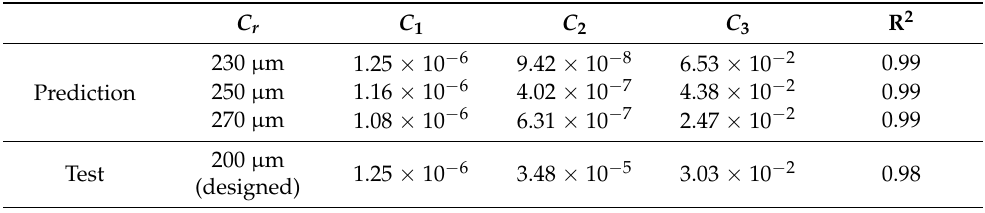
Table 2. Curve fitting functions of the static load versus the displacement from the prediction and test results. C r C 1 C 2 C 3 R 2 230 µ m 1.25 × 10 − Prediction